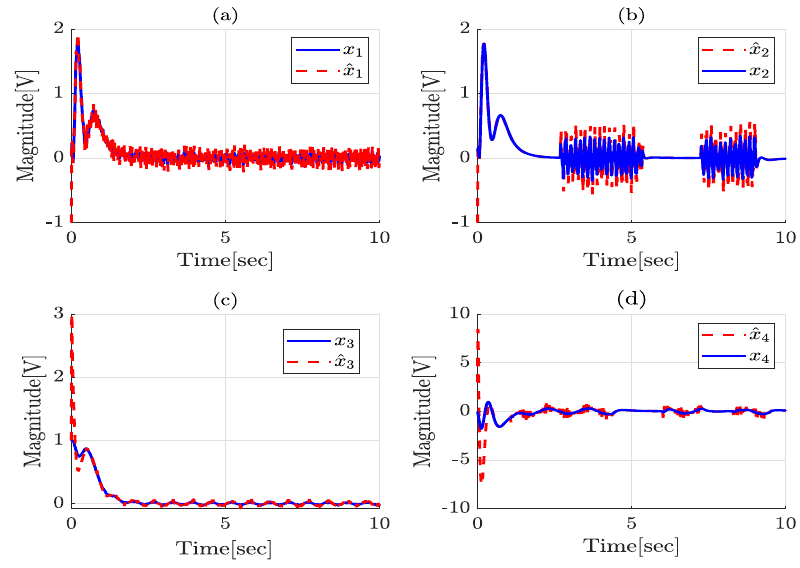
Figure 2. Evolution of the states (solid line) and their estimates (dashed line): ( a ) Behavior of x 1 and its estimate, ( b ) Behavior of x 2 and its estimate, ( c ) Behavior of x 3 and its estimate, ( d ) Behavior of x 4 and its estimate.